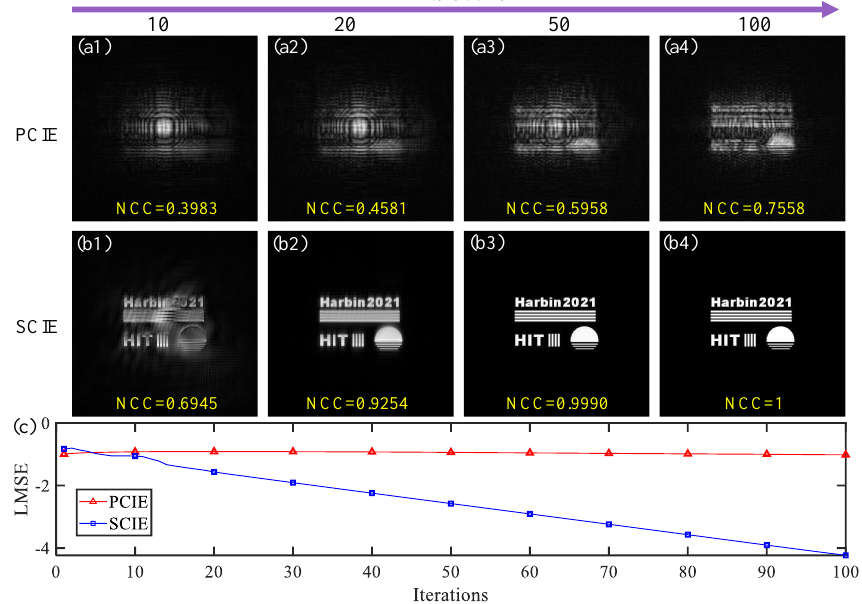
Figure 4. Reconstructed results of PCIE and SCIE. ( a1 – a4 ) and ( b1 – b4 ) are reconstructed images; ( c ) is the logarithm of mean square error (LMSE) curves of the reconstruction results from the two